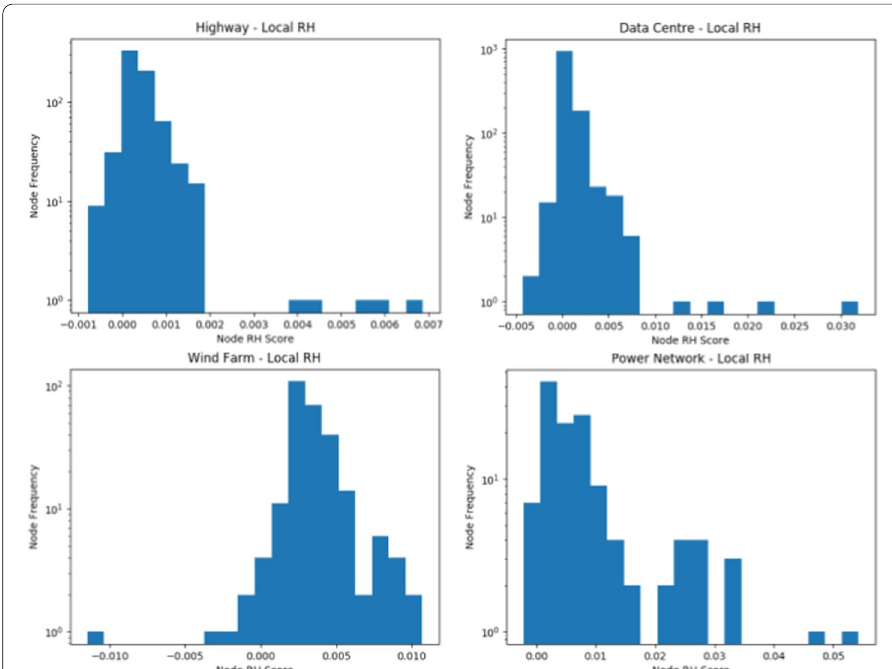
Fig. 3 Distribution of local RH scores for the four activity networks. All four distributions have a clear peak, close to but not always coinciding with the zero value, with frequency values spanning over several orders of magnitude. WF is the only network exhibiting a left tail in the RH distribution, and comparison with Fig. 2 shows that it is also the only project that, among the four, reported delays significantly larger than